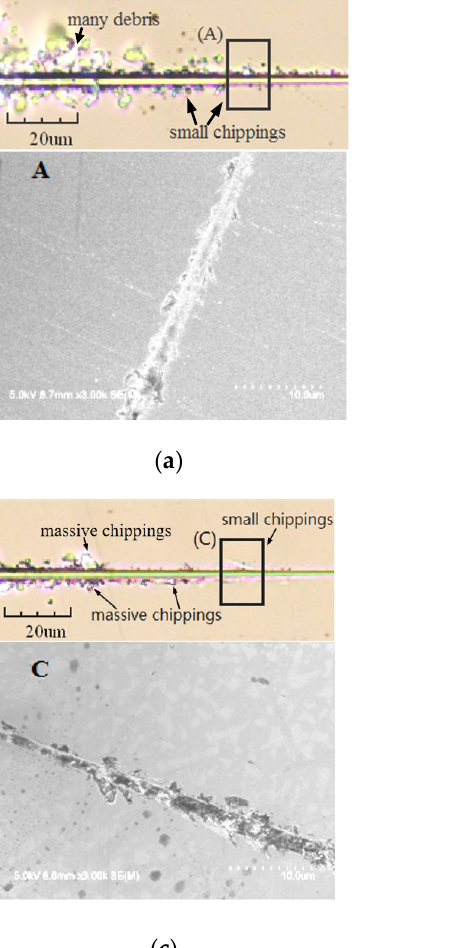
Figure 9. Scratch depth-displacement-load along different orientations: ( a ) X axis on Z-cut, ( b ) Y axis on Z-cut, ( c ) Y axis on X-cut, ( d ) Z axis on X-cut, of pre-scratching (I represents the elastic deformation stage, II represents the ductile deformation stage, and III represents the brittle deformation stage.).